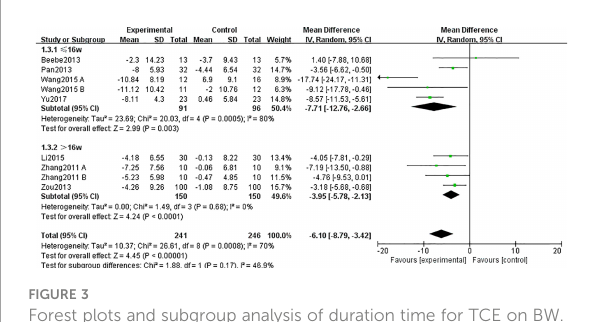
FIGURE 3 Forest plots and subgroup analysis of duration time for TCE on